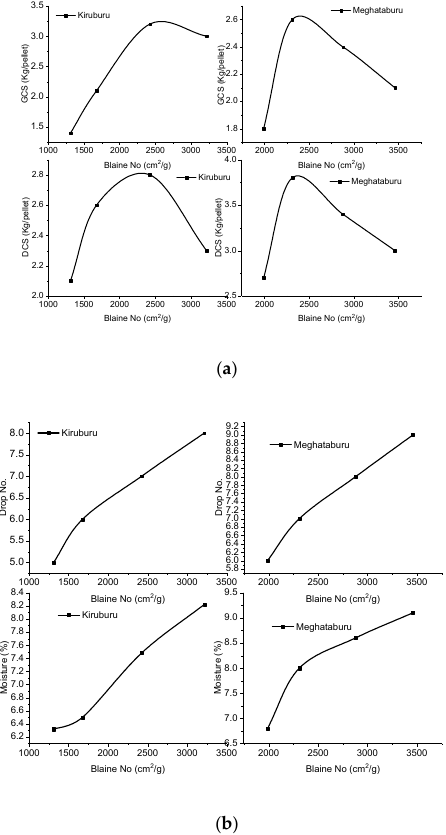
Figure 2. Effect of Blaine fineness (iron ore No.1 and No.2) on ( a ) G.C.S. and D.C.S. ( b ) drop no. and